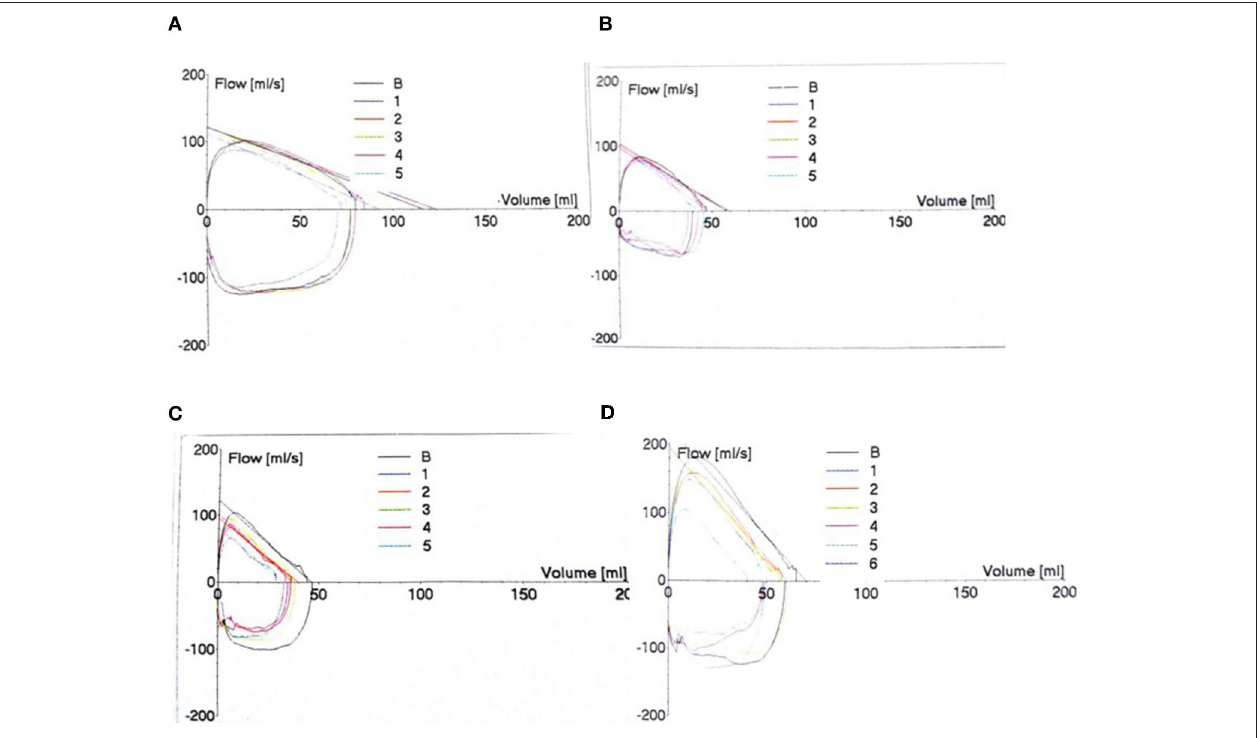
FIGURE 1 | Tidal Breathing Flow Capacity Ring (TBFVL) Status. The changes in TBFVL were recorded in the non-BPD (A) , mild (B) , moderate (C) and severe (D) BPD groups.